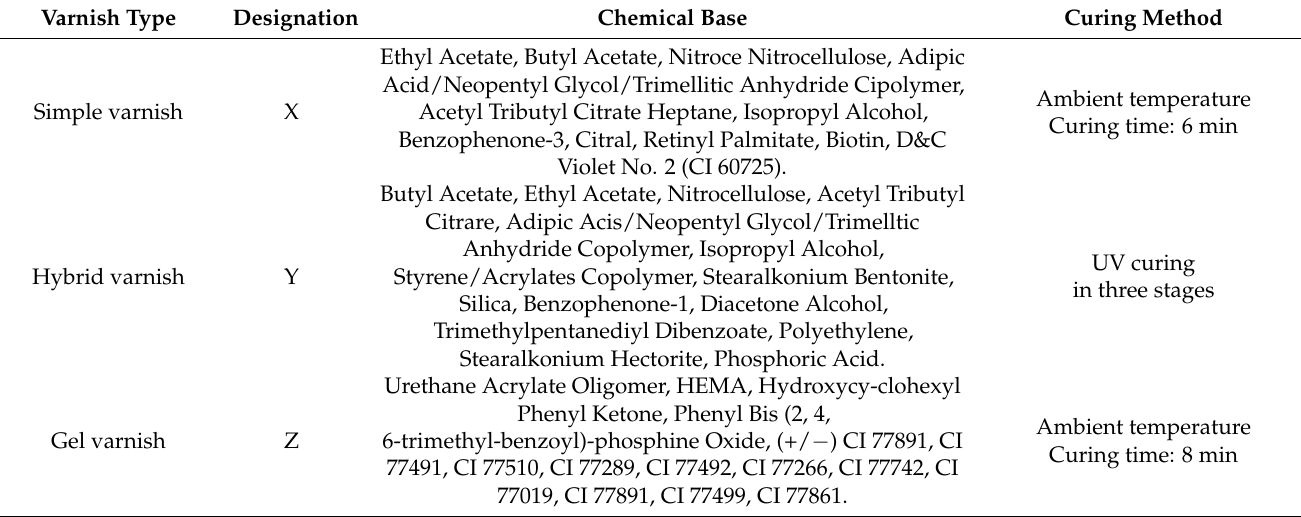
Table 6. Description of polymer varnishes used to produce varnish coats on steel samples.